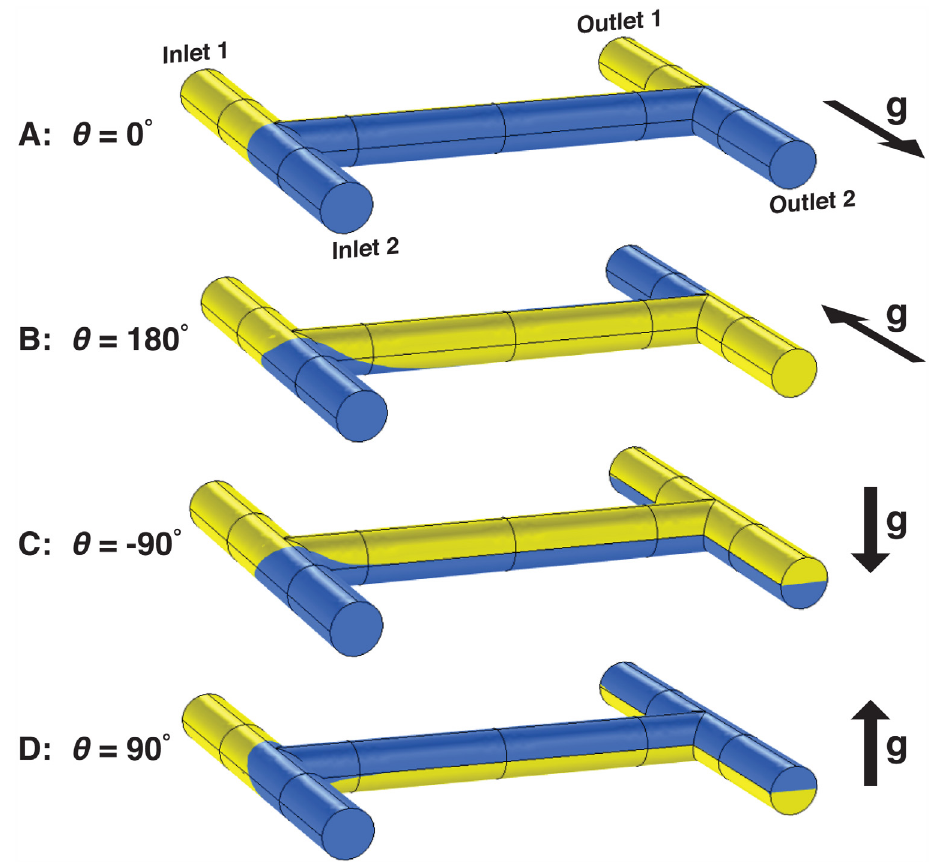
Fig 2. Principle of orientation-based control of microfluidics. These simulations show fluid flowing inside a simple microfluidic channel network containing two inlets and two outlets. Inlet 1 contains a less-dense yellow fluid and Inlet 2 contains a more-dense blue fluid. When the chip is oriented such that Inlet 2 is aligned with the Earth ’ s gravitational force (A) , the yellow and blue fluids remain unperturbed and exit the chip in the same directions from which they entered (yellow at Outlet 1 and blue at Outlet 2). However, when the chip is rotated 180° (B) , the force of gravity causes the fluids to swap places in the horizontal channel, placing the more-dense blue fluid on the bottom of the channel and the less-dense yellow fluid on the top. Consequently, the two fluids exit in the opposite directions from which they entered: Outlet 1 contains blue fluid and Outlet 2 contains yellow fluid. When the chip is oriented at − 90° relative to gravity (C) , the fluids rotate 90° clockwise to orient the more-dense blue fluid on the bottom of the channel and the less-dense yellow fluid on the top. When the channel splits into two outlets, each outlet receives an identical mixture containing 50% yellow fluid and 50% blue fluid. Finally, when the chip is oriented at 90° (D) , the fluids rotate 90° counterclockwise to once more orient the more-dense blue fluid on the bottom of the channel, and again both outlets contain identical mixtures containing 50% yellow and 50% blue. In this manner, the orientation of a microfluidic chip may be used to route fluids in different directions on-chip without using any off-chip control